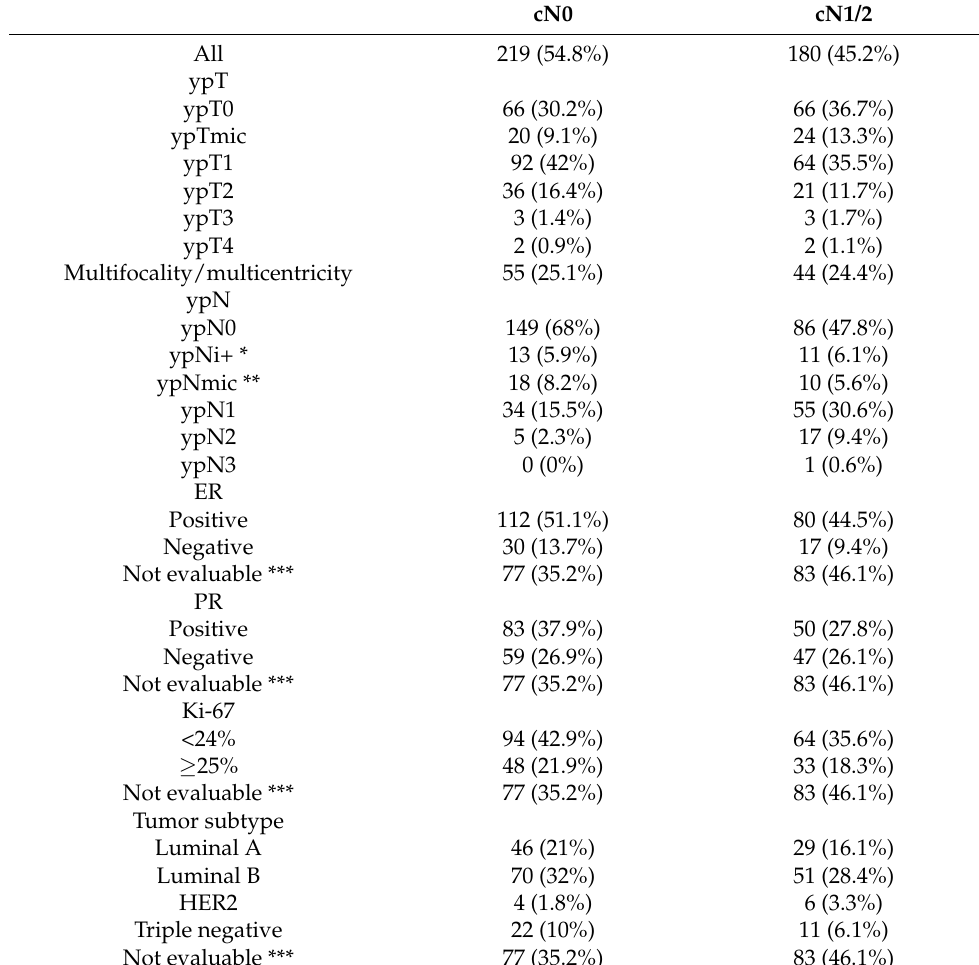
Table 4. Pathological characteristics according to cN status prior to neoadjuvant treatment.